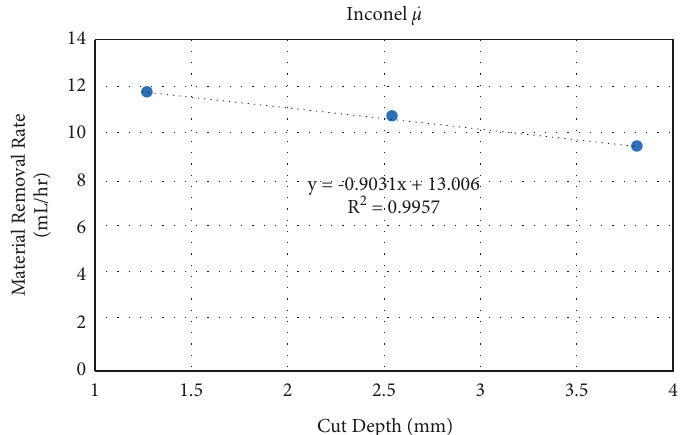
Figure 8: Mean _ μ due to cut depth in Inconel.